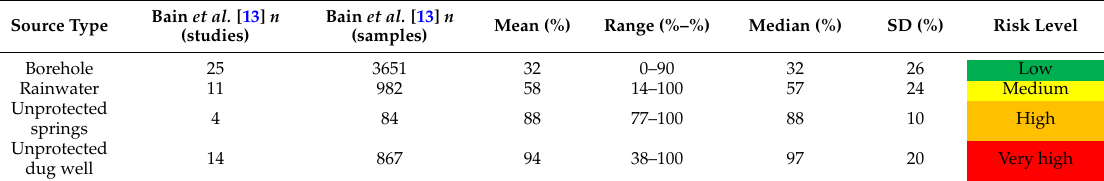
Table 2. Descriptive statistics calculated in this study for samples with ě 10 E. coli /100 mL the using Bain et al . [13] (Supplementary Material Tables S3 and S4), and the resulting general risk level indicators. et al. [13] n Bain et al. [13] n Source Type Bain (studies) (samples) Mean (%) Range (%–%) Median (%) SD (%) Risk Level Borehole 25